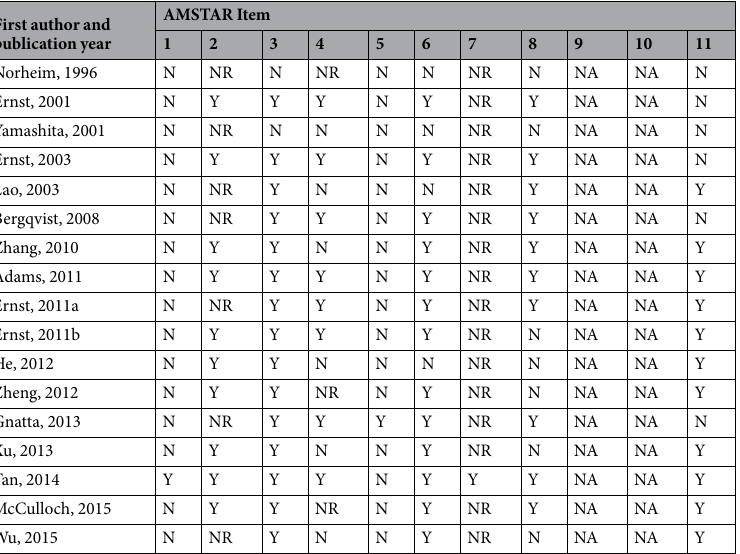
Table 2. Methodological quality of included systematic reviews on acupuncture and its adverse events and/ or complications. Keys: Y, yes; N, no; NR, not reported; NA, not applicable. AMSTAR item: 1. Was an ‘a priori’ design provided? 2. Was there duplicate study selection and data extraction? 3. Was a comprehensive literature search performed? 4. Was the status of publication (i.e. grey literature) used as an inclusion criterion? 5. Was a list of studies (included and excluded) provided? 6. Were the characteristics of the included studies provided? 7. Was the scientific quality of the included studies assessed and documented? 8. Was the scientific quality